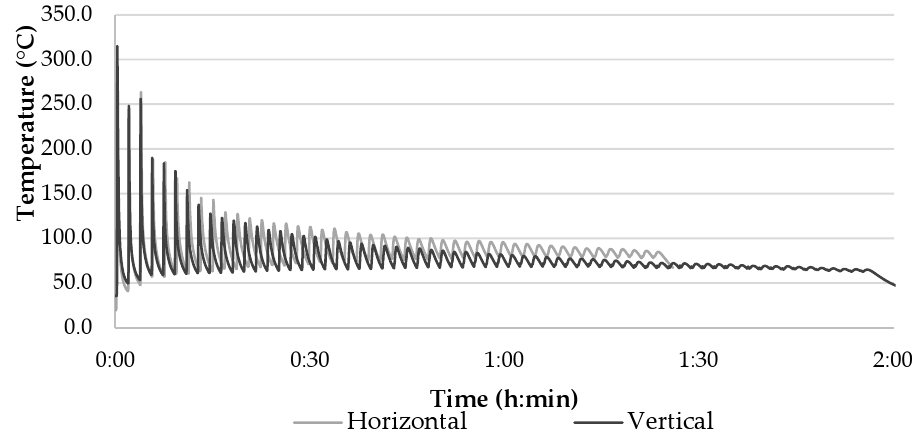
Figure 17. Thermocouple temperatures of layers in parts manufactured to test mechanical properties with Argon Q1 + 18 L/min + hatching condition.